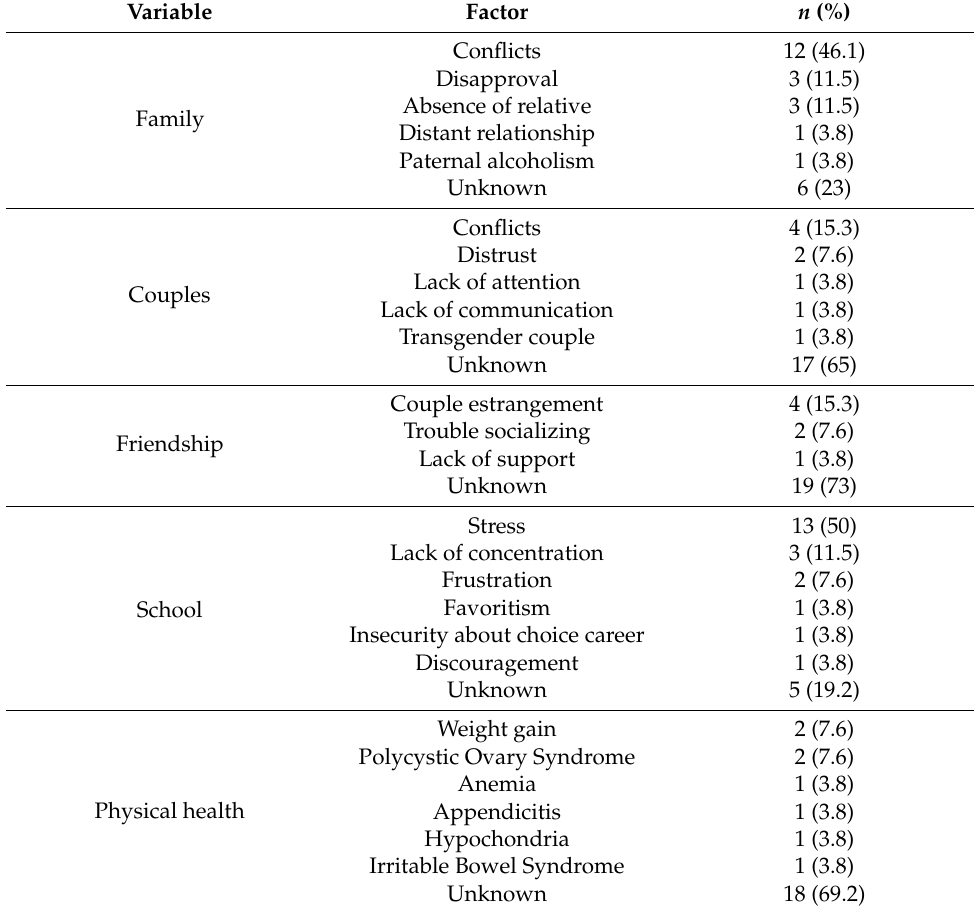
Table 1. Description of triggering factors for anxiety and/or depression by social